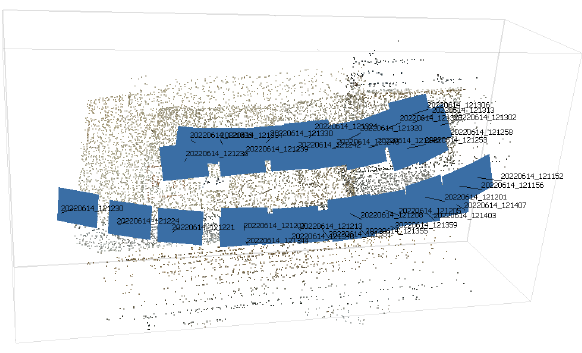
Figure 9. Camera positions in domical imagery